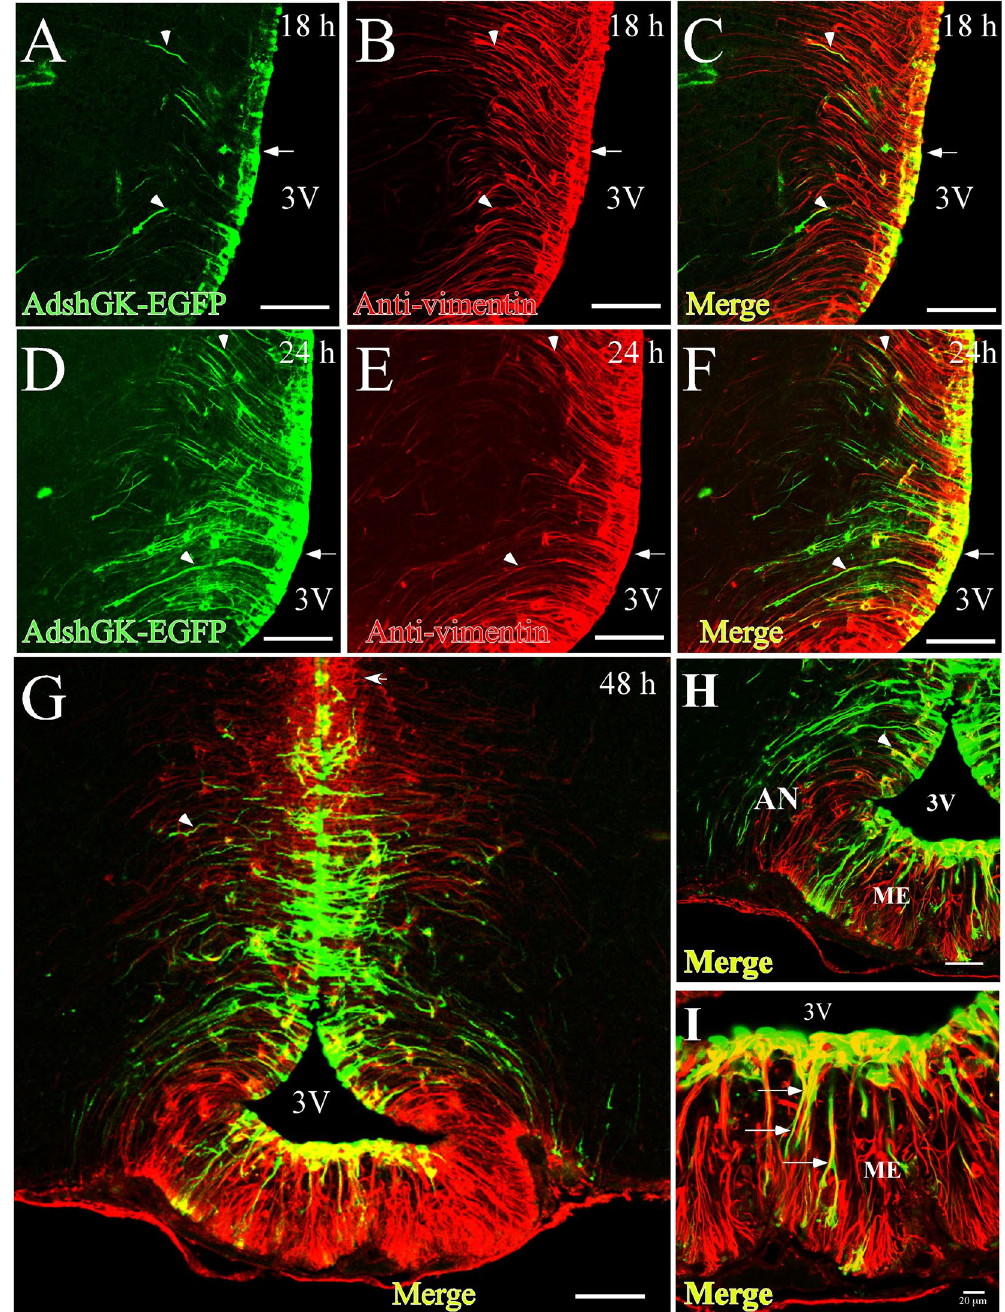
Figure 1. Time-course of adenoviral transduction in the basal hypothalamus. ( A–L ) Frontal sections (40 µ m) from the hypothalamus at 18 h ( A–C ), 24 h ( D–F ) and 48 h ( G–I ) following injection of adenoviral particles (Ad-shGK-EGFP) into the 3V. EGFP fluorescence (green) and immunoreactivity for vimentin (red) and colocalization of EGFP and vimentin (yellow) are shown. Arrows show the processes of transduced tanycytes. ( G ) Panoramic view of the basal hypothalamus, showing tanycyte transduction. ( I ) Higher magnification image showing that Ad-EGFP transduction occurs in β 2-tanycytes. AN, arcuate nucleus; 3V, third ventricle; ME, median eminence. Scale bars ( A – F and H ) 50 µ m, ( G ) 100 µ m, ( I ) 20 µ